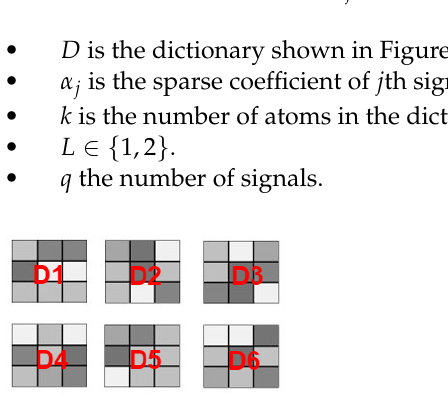
Figure 3. Example of learned dictionary D. k = 6 and S =